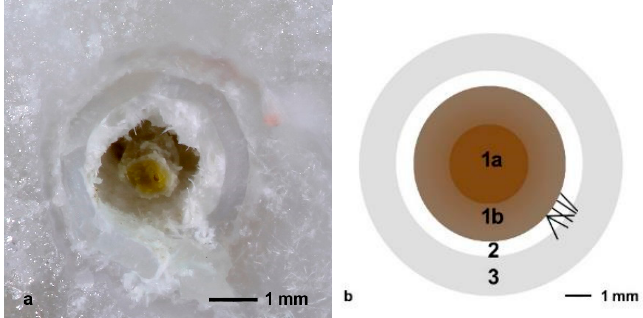
Figure 9. Central SFF with surrounding zone of an empty tube and an external zone consisting of a 0.5 to 20 mm ‐ thick chalcedony layer: ( a ) Micrograph of an SFF cross section. ( b ) Schematic cross section of an SFF: 1a = core SFF (Fe rich clay minerals), 1b = outer zone of the central SFF (Fe containing clay minerals), 2 = surrounding zone of an empty tube (occasionally containing fibrous mordenite), and 3 = external zone consisting of a 0.5 to 20 mm ‐ thick SiO 2 layer.